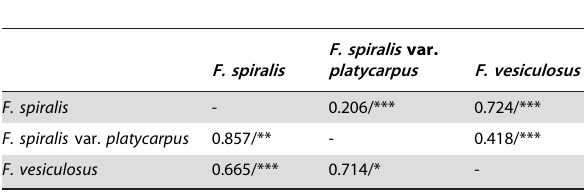
Table 3. Inter-species average pairwise